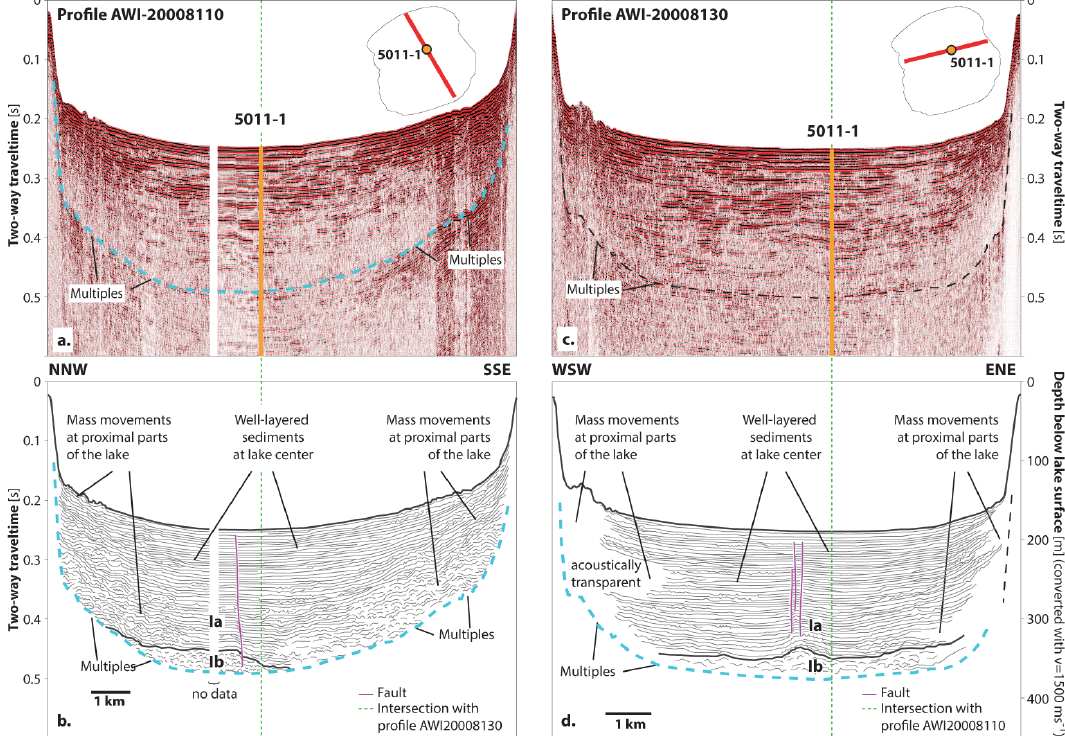
Fig. 2. Single-channel seismic reflection profiles AWI-20008110 and AWI-20008130 (acquired with a Bolt 600B airgun). Seismic profiles are shown in (a) and (c) ; line drawings and interpretations in (b) and (d) . Green dashed line marks the intersection of the two lines that was chosen for drill site 5011-1; lilac lines show the faults that are likely related to the central uplift structure of the impact crater (see Gebhardt et al., 2006). Seismic profiles clearly show the boundary between subunits Ia and Ib. Units II and III are masked by the multiples.